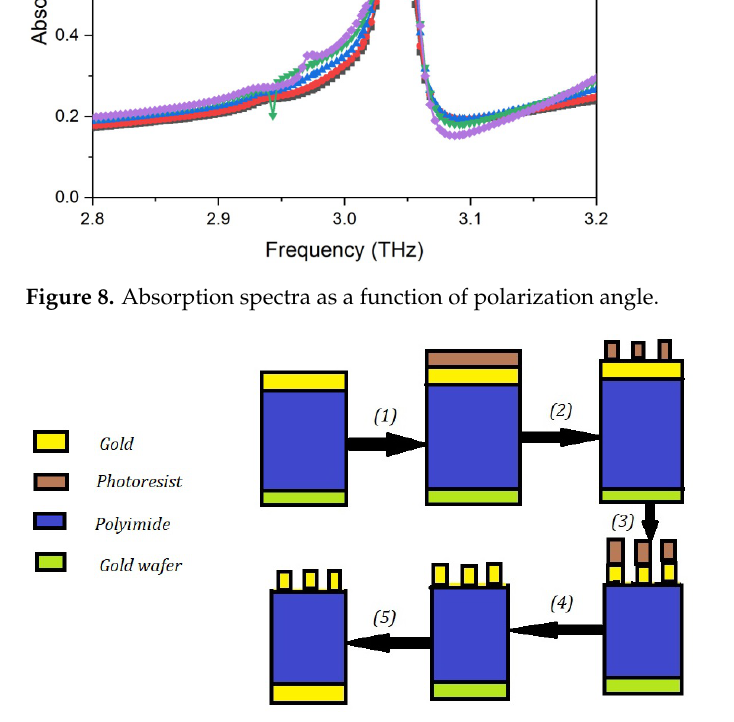
Figure 9. Process flow: (1) and (2) are the photolithography to define the metamaterial geometry, while (3) and (4) show the wet etching and washing of the photoresist to fabricate the metamaterial structures, and (5) is the evaporation of metallic substrate layer on another side of the polyimide